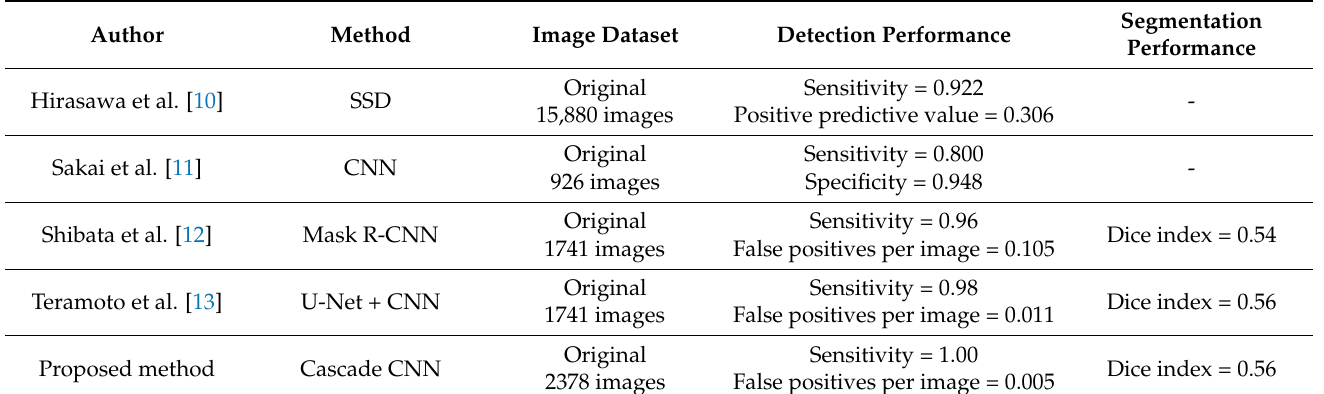
Table 4. Performance comparison of gastric cancer detection and